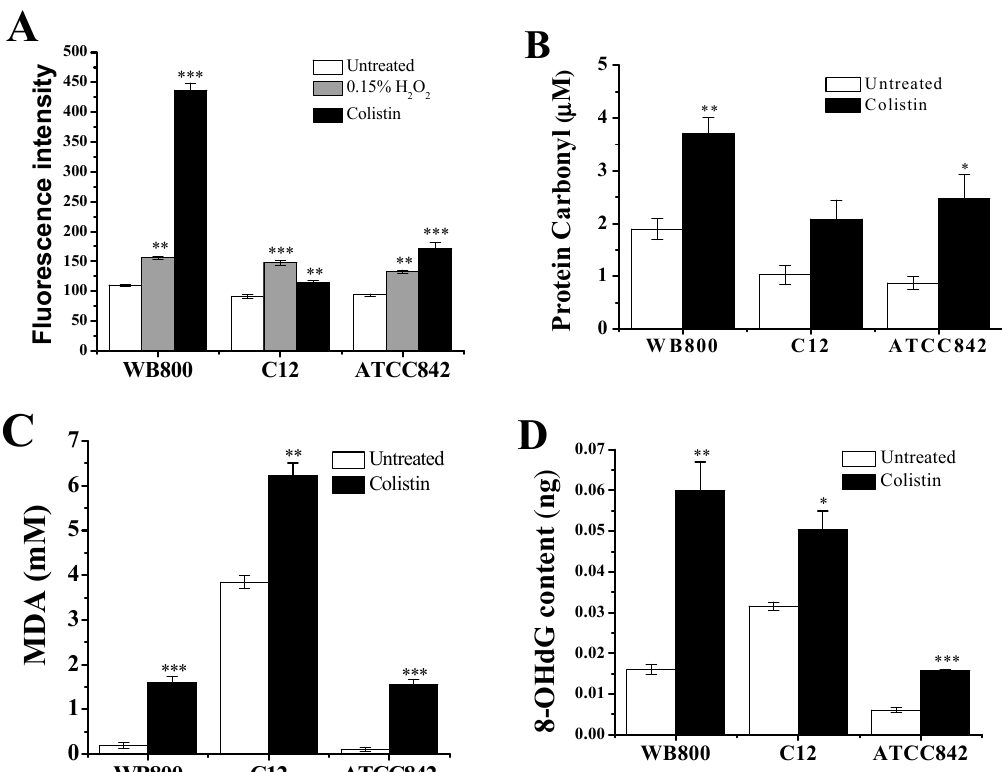
Figure 1. Colistin-induced oxidative stress in Gram-positive bacteria and damages to cells. ( A ) Hydroxyl radicals-specific hydroxyphenyl fluorescein (HPF) signal due to hydroxyl radicals accumulation; ( B ) protein carbonylation; ( C ) malondialdehyde (MDA) production; ( D ) 8-hydroxy-2- deoxyguanosine (8-OHdG) formation. Cells were treated with or without colistin for 2 h. The data are representative of three independent experiments. Points represent the means and bars represent the standard deviation of triplicate samples. When the probability ( p -value) was less than 0.05, 0.01 and 0.001, the values were considered significantly (*), very significantly (**) and extremely significantly (***) different, respectively. WB800: Bacillus subtilis WB800; C12: Paenibacillus polymyxa C12; ATCC842: Paenibacillus polymyxa ATCC842.